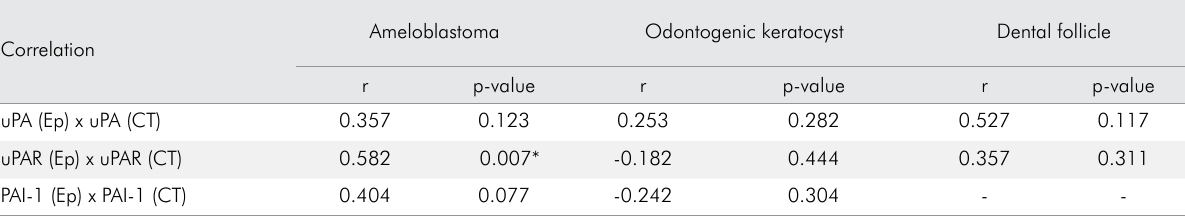
Table 6. Spearman’s correlation coefficients ( r ) to test for correlations between uPA, uPAR and PAI-1 immunoexpression scores in ameloblastomas, odontogenic keratocysts and dental follicles.